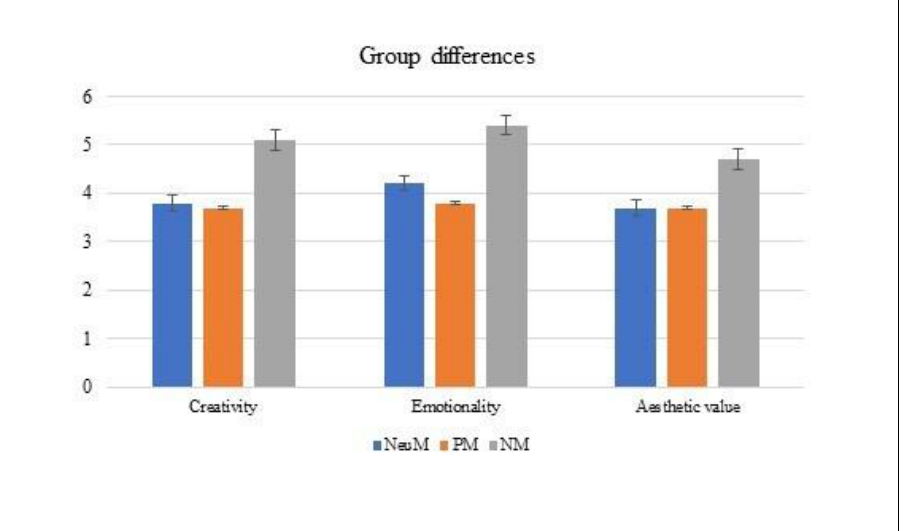
Figure 3. Rating of the creativity, emotionality and aesthetic value of the artistic drawings with respect to positive, negative and neutral music groups. The error bars represent the standard errors of the means.